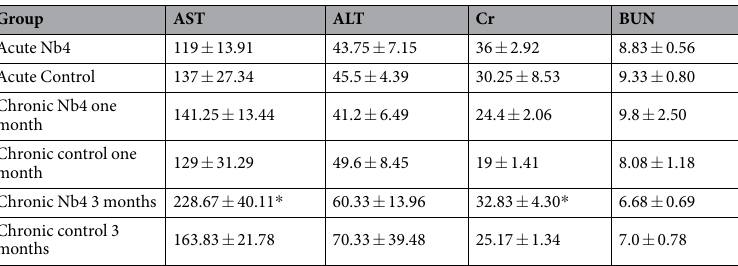
Table 1. Serum ALT, AST, BUN and Cr levels in rats. * P < 0.05 vs. the control. AST: aspartate aminotransferase; ALT: Alanine transaminase; Cr: Creatinine; BUN: blood urea